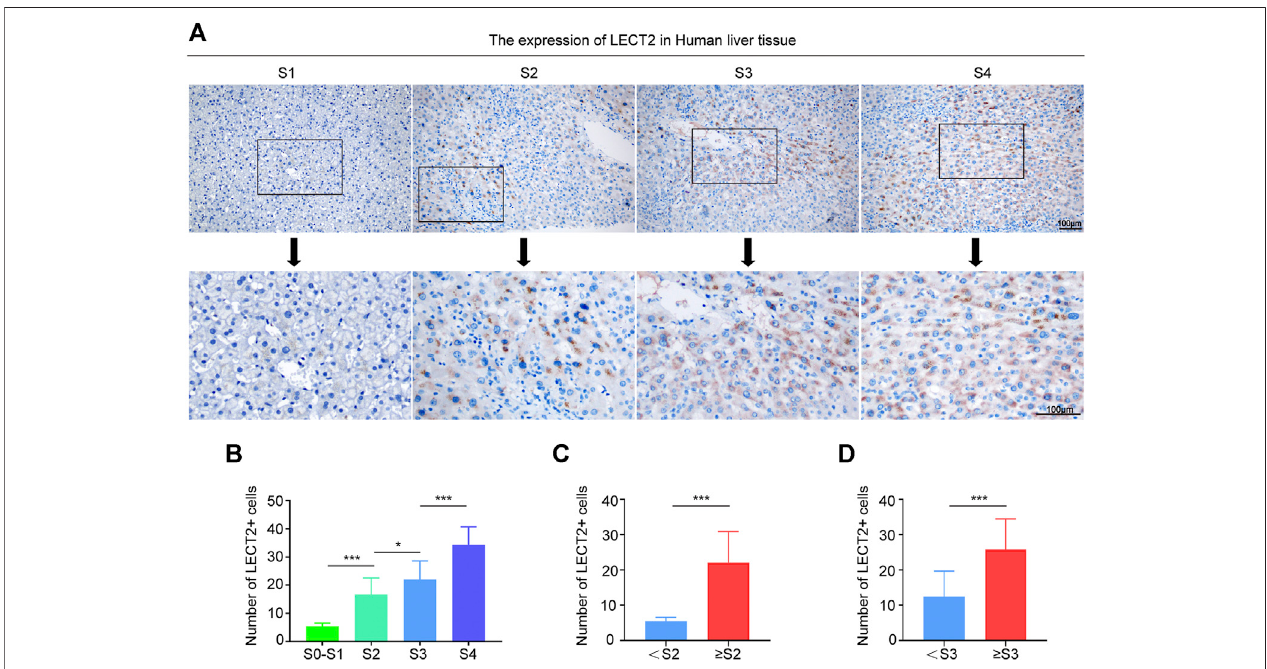
FIGURE 4 | Expression of LECT2 protein levels in the human liver tissue. (A) Immunohistochemical staining of LECT2 in liver tissues sections from CHB patients in different stages of liver fi brosis. (B) , (C) , and (D) show the quantitative analysis of LECT2+ cells in (A) . * p < 0.05, *** p <